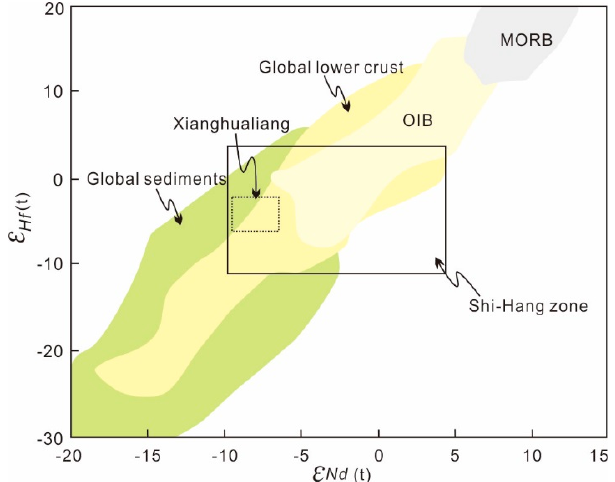
Figure 12. ε Nd (t) vs. ε Hf (t) for the granites from Xianghualing area South China. Plots of ε Nd (t) vs. ε Hf (t) fall into the quadrangle. The average values concentrate in the dotted quadrangle. The data of ε Nd (t) and ε Hf (t) are from [29 – 31,33,54,81,82]. MORB, mid-ocean ridge basalt.